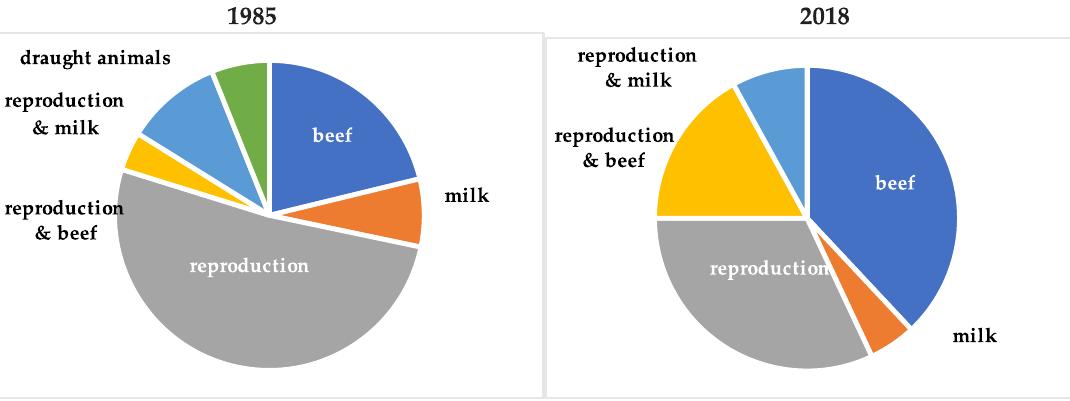
Figure 5. Purpose of household Cattle. Land 2020 , 9 , 75